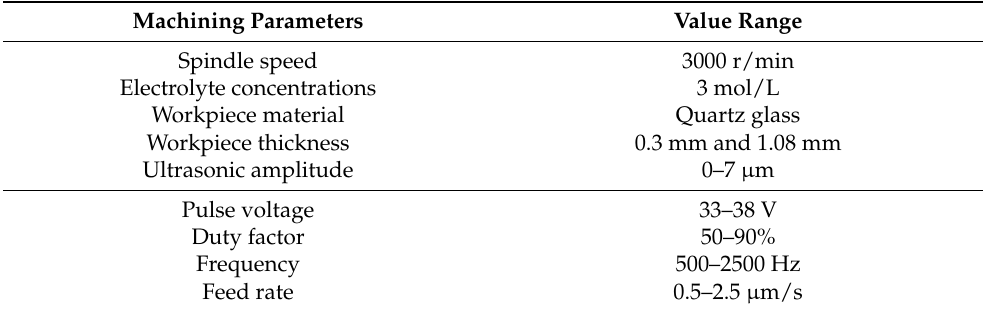
Table 1. Parameter setting of wire electrochemical discharge machining (WECDM).